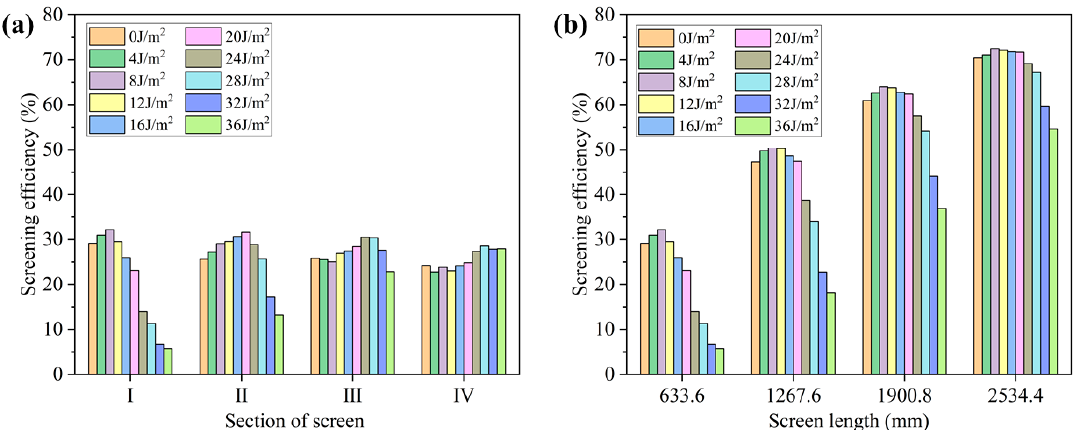
Figure 11. ( a ) Screening efficiency of different sections of the screen with different surface energy levels, ( b ) screening efficiency of different screen lengths with different surface energy levels.